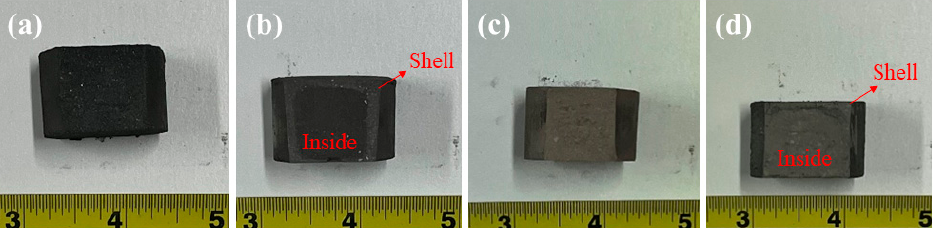
Figure 4. Cross-sectional photographs of ( a ) Si briquette; ( b ) Si briquette after being treated at 1473 for 1 h; ( c ) Si 3 N 4 briquette; ( d ) Si 3 N 4 briquette after being treated at 1473 K for 1 h.